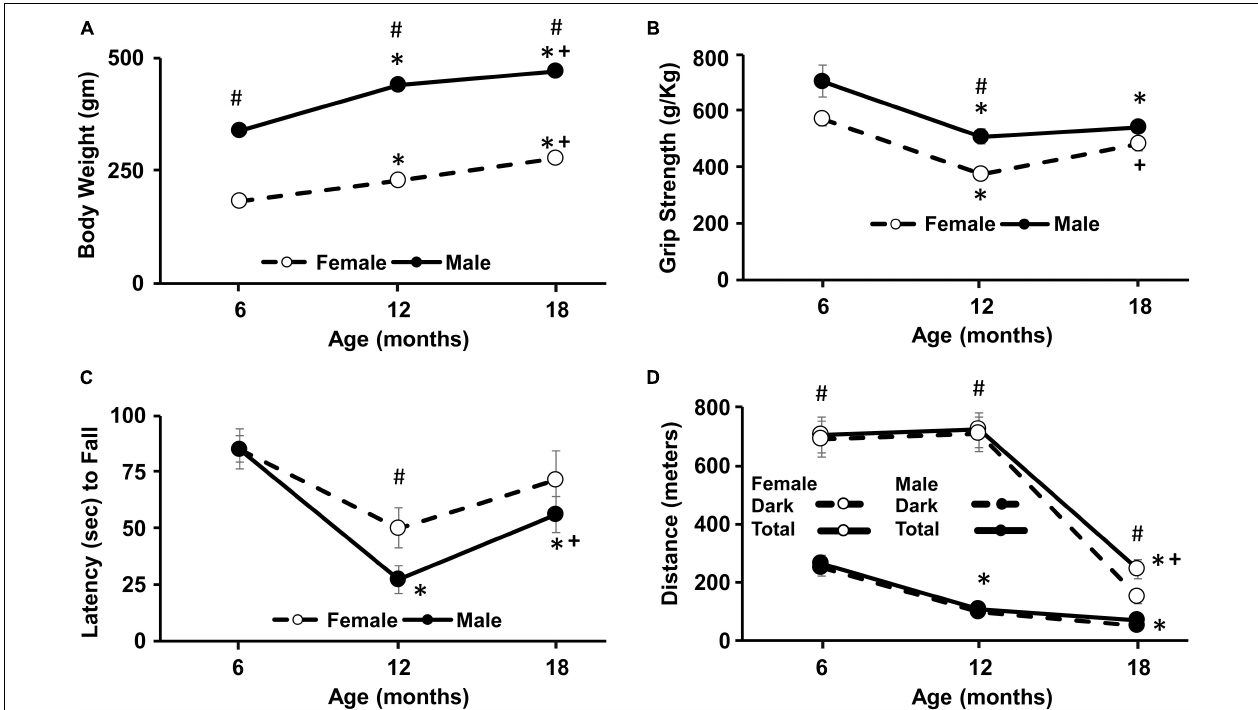
FIGURE 1 | Longitudinal change in weight, grip strength, Rotarod, and wheel-running activity. For this and all subsequent figures, filled circles represent males and open circles represent females, and each point represents the mean ± SEM. (A) Body weight increased with age and was greater for males. (B) Grip strength declined between 6 and 12 months for both sexes and was greater in males at 12 months. (C) Latency to fall on the Rotarod decreased from 6 to 12 months in both sexes and a sex difference was evident at 12 months. (D) For wheel running activity, the total distance over the 24 h period (solid line) was mainly due to activity occurring during the lights off period (dashed lines). Females were consistently more active than males, exhibiting an increase in total activity at each age. For males, the greatest decline in activity occurred from 6 to 12 months and from 12 to 18 months in females. Pound sign indicates a significant ( p < 0.05) sex difference at each age. For each sex, asterisks indicated a significant ( p < 0.05) difference from 6 months and + sign indicates a difference between 12 and 18 months.